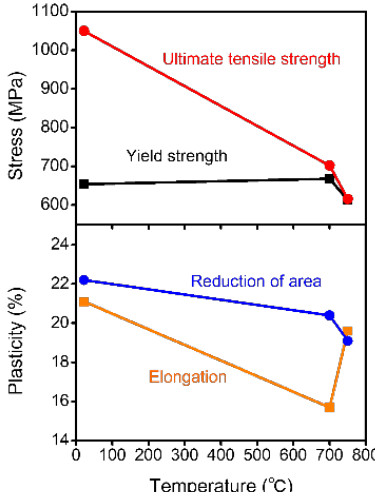
Figure 2. Tensile properties as a function of temperature in terms of ultimate tensile strength, yield strength, reduction of area, and elongation of the Ni-Fe-based alloy.